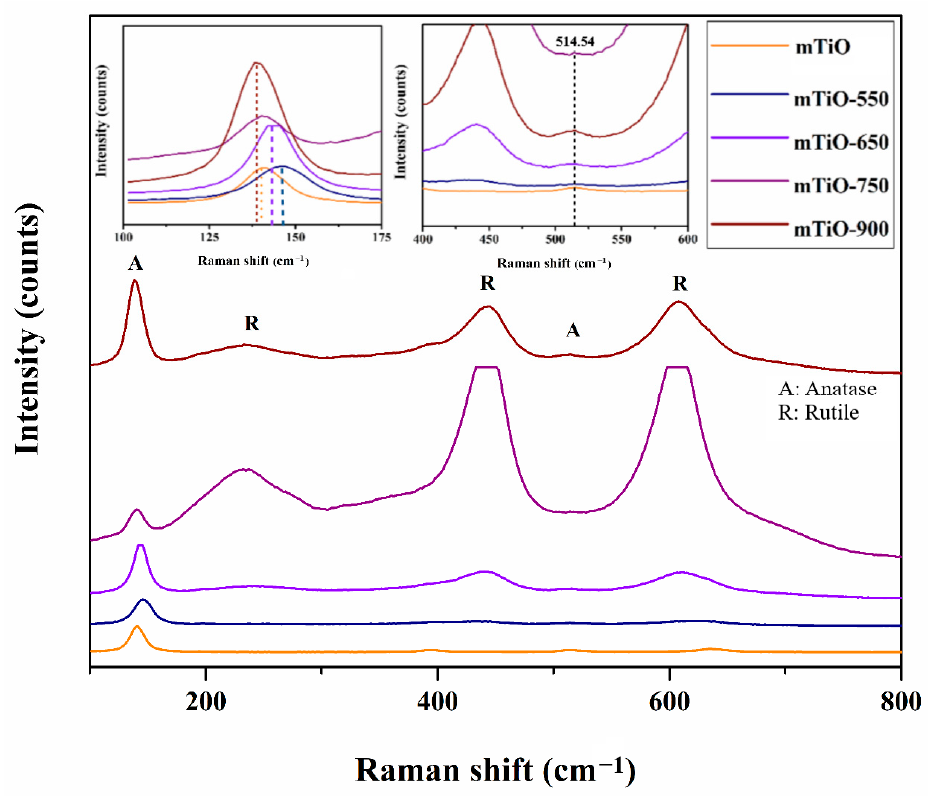
Figure 5. Raman spectra of treated mTiO